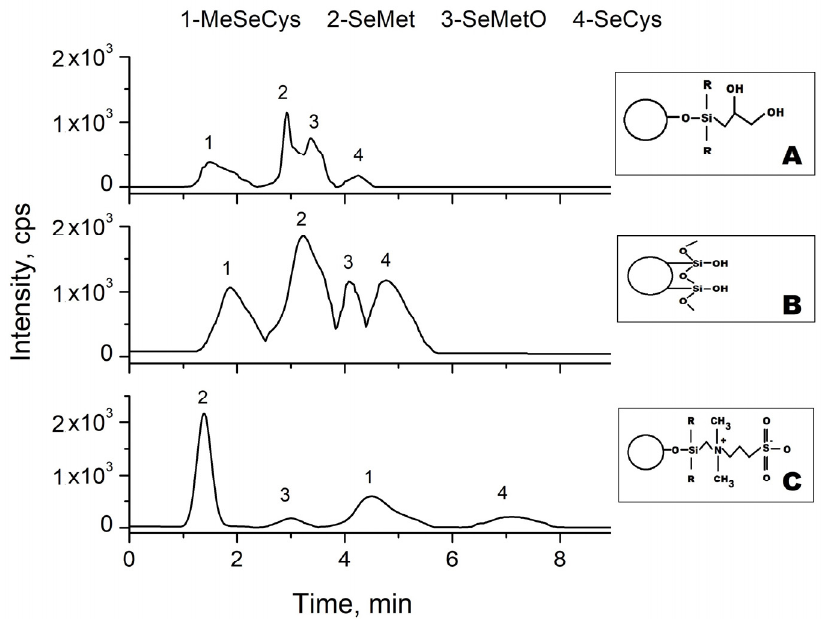
Figure 4. Comparison of the separation efficiency of selenium species in Lung-Ching-1 green tea with the addition of β ME on different HILIC stationary phases: ( A ) bare silica, ( B ) diol, ( C ) sulfobetaine (zwitterionic); Mobile phase: 85% MeOH/water in isocratic elution.